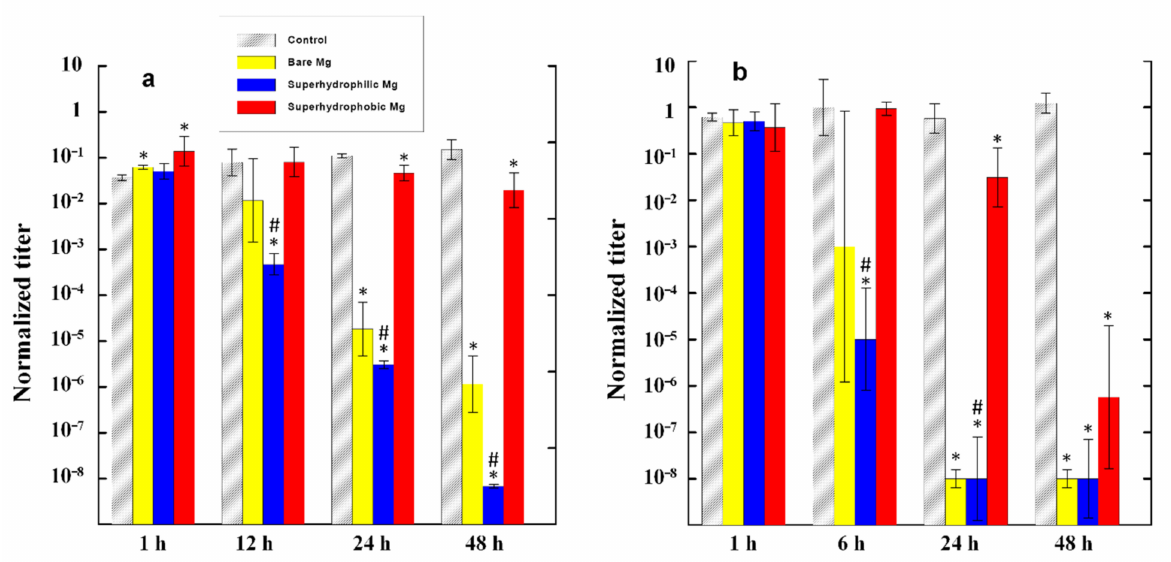
Figure 3. Evolution of the titer of P. aeruginosa ( a ) and K. pneumoniae ( b ) in cups with bacterial suspension with a time of con- tact between the suspension and MA8 plates with different wettability: polished MA8 alloy (yellow posts), superhydrophilic (blue posts), and superhydrophobic (red posts) coatings. The reference gray posts represent the corresponding variation of titer in the control bacterial suspension. Error bars represent the standard deviations of the logarithm of the bacterial titer; * p < 0.05 compared with the blank control; # p < 0.05 indicates a significant difference between the superhydrophobic and the superhydrophilic